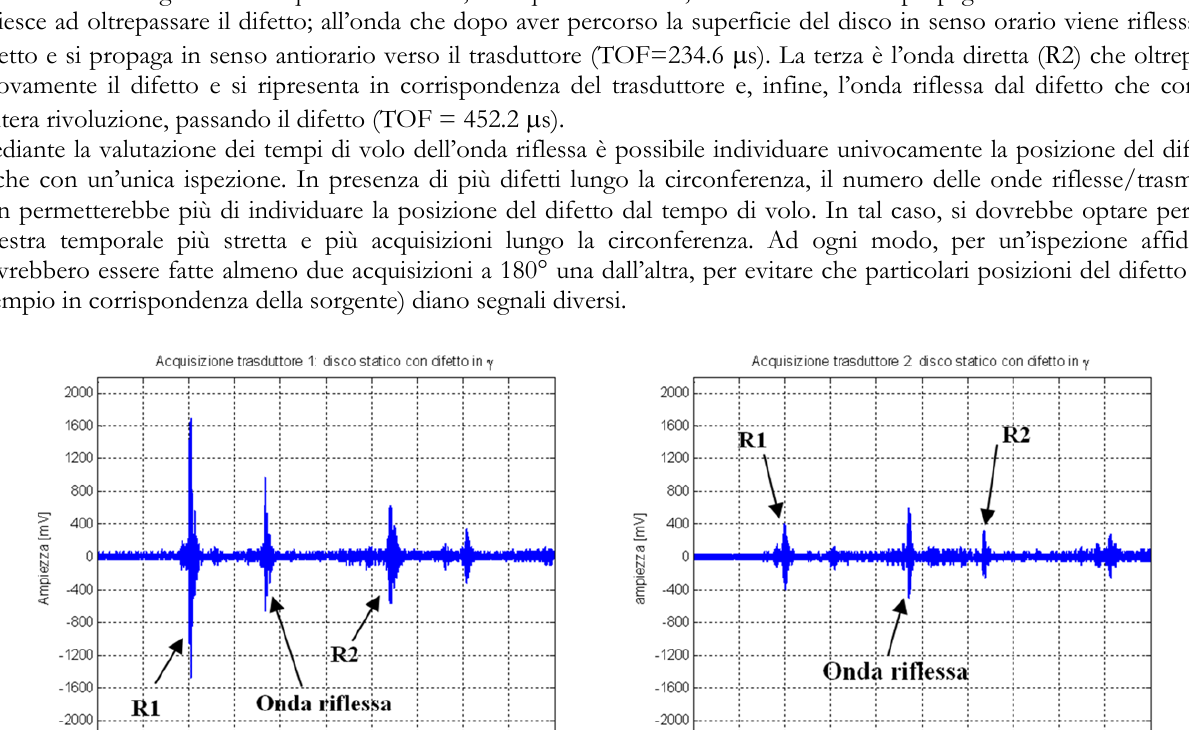
Figura 4: Segnale acquisito dal trasduttore 1. Disco fermo con difetto in γ =-70°. Figure 4: Signal acquired by transducer 1. Static disk with defect at γ =-70°.